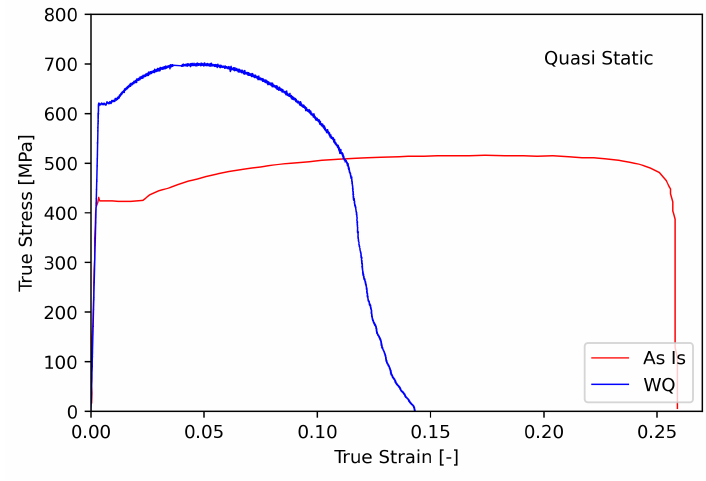
Figure 3. Quasi-static tensile stress over strain curves.